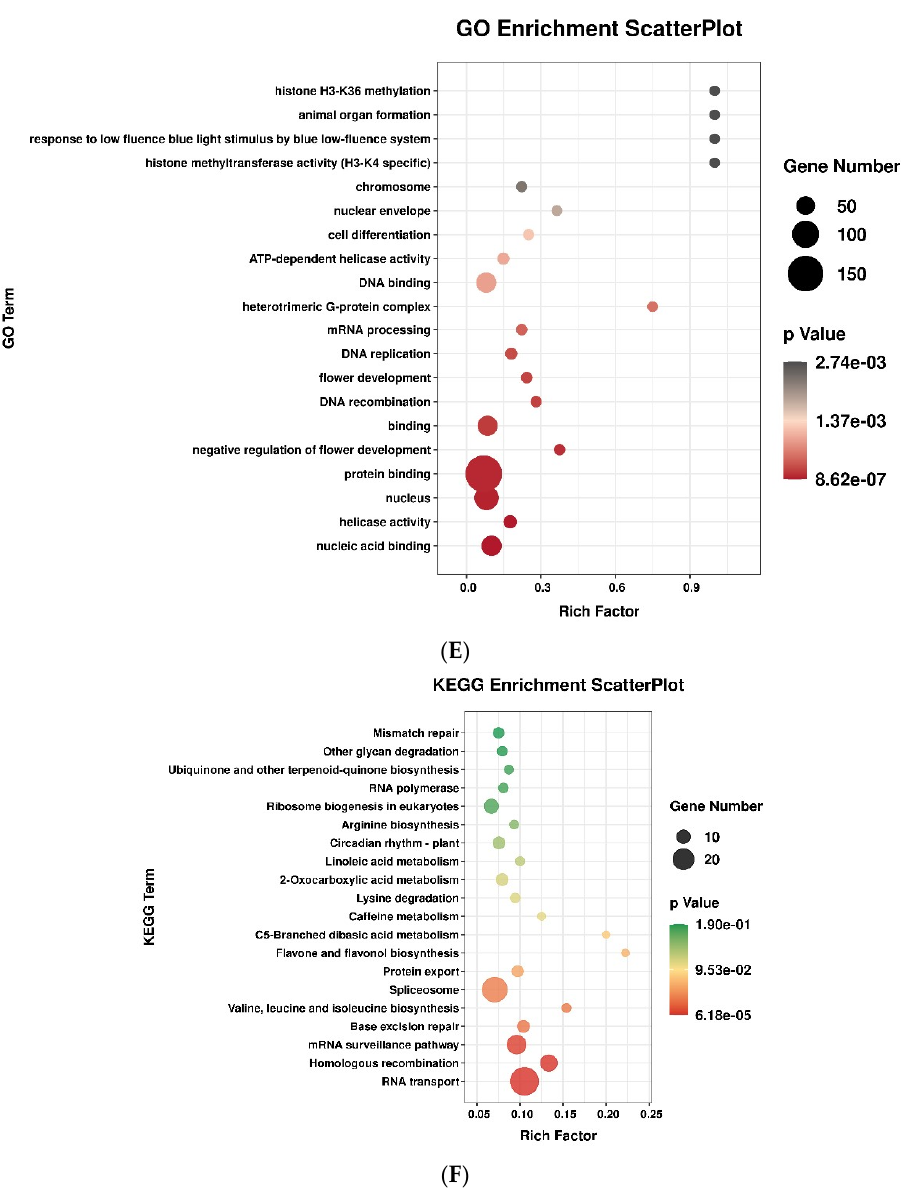
Figure 1. Identification and analysis of mRNAs under vernalization. ( A ) The number of differen- tially expressed mRNAs between the vernalized and nonvernalized samples; ( B ) The number of significantly expressed mRNAs between the vernalized and nonvernalized samples; ( C ) heat map; ( D ) Gene Ontology (GO) classifications; ( E ) GO enrichment analysis; and ( F ) Kyoto Encyclopedia of Genes and Genome (KEGG) pathway assignments for all of the differentially expressed mRNAs.